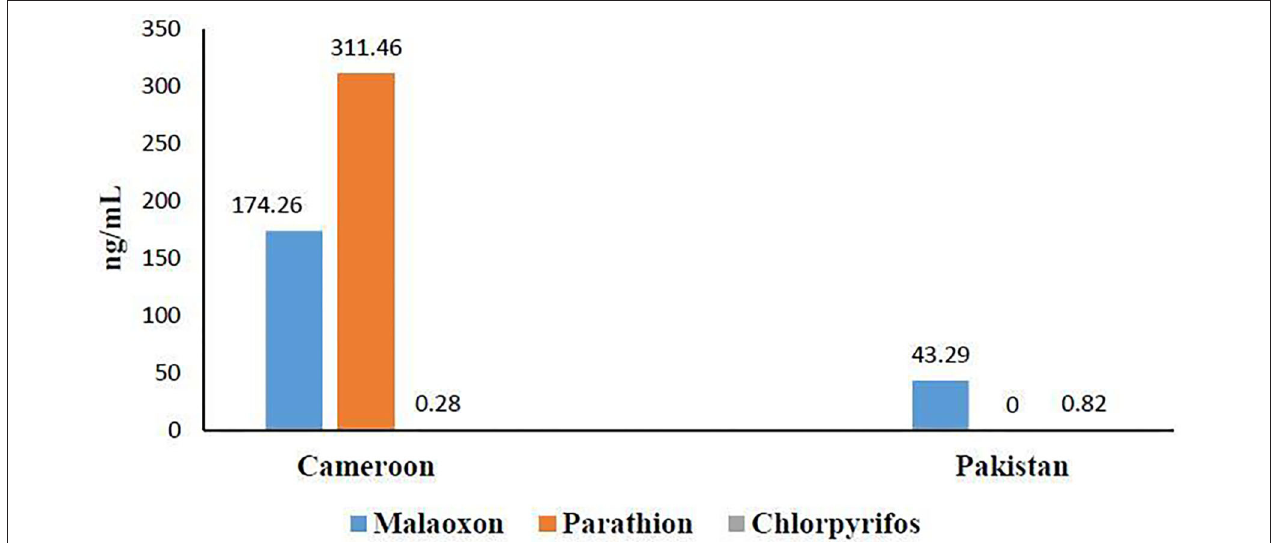
FIGURE 3 | Blood pesticides levels in Cameroonian and Pakistani